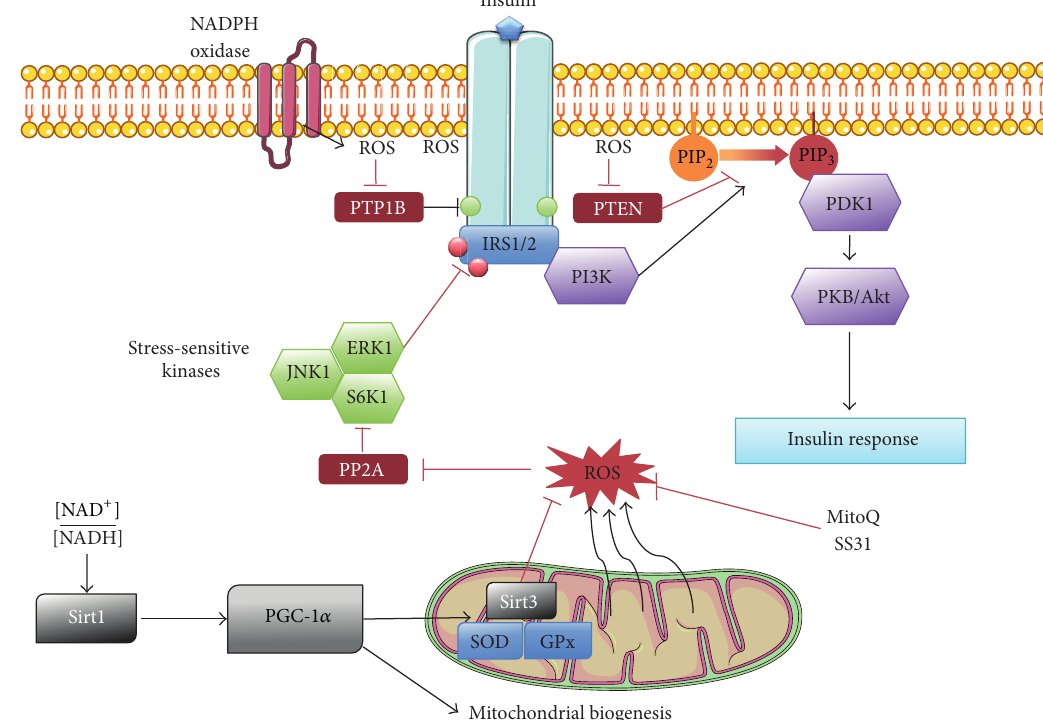
Figure 1: Molecular mechanisms linking ROS, antioxidants, and the insulin signalling pathway. To allow a response to insulin stimulation, ROS are relieving insulin receptor’s inhibition by phosphatases such as PTP1B. When the cellular environment shifts to an oxidative one, because of increased mitochondrial respiration and ROS release for example, the stress-sensitive kinases are activated upon redox-sensitive phosphatases inhibition. Theses kinases are inhibiting signal amplification by inhibitory phosphorylation of IRS proteins. Mitochondrial ROS can be regulated by PGC-1 𝛼 -dependent detoxification system (Sirt3, SOD, GPx) or by specific mitochondrial antioxidants (SS31,